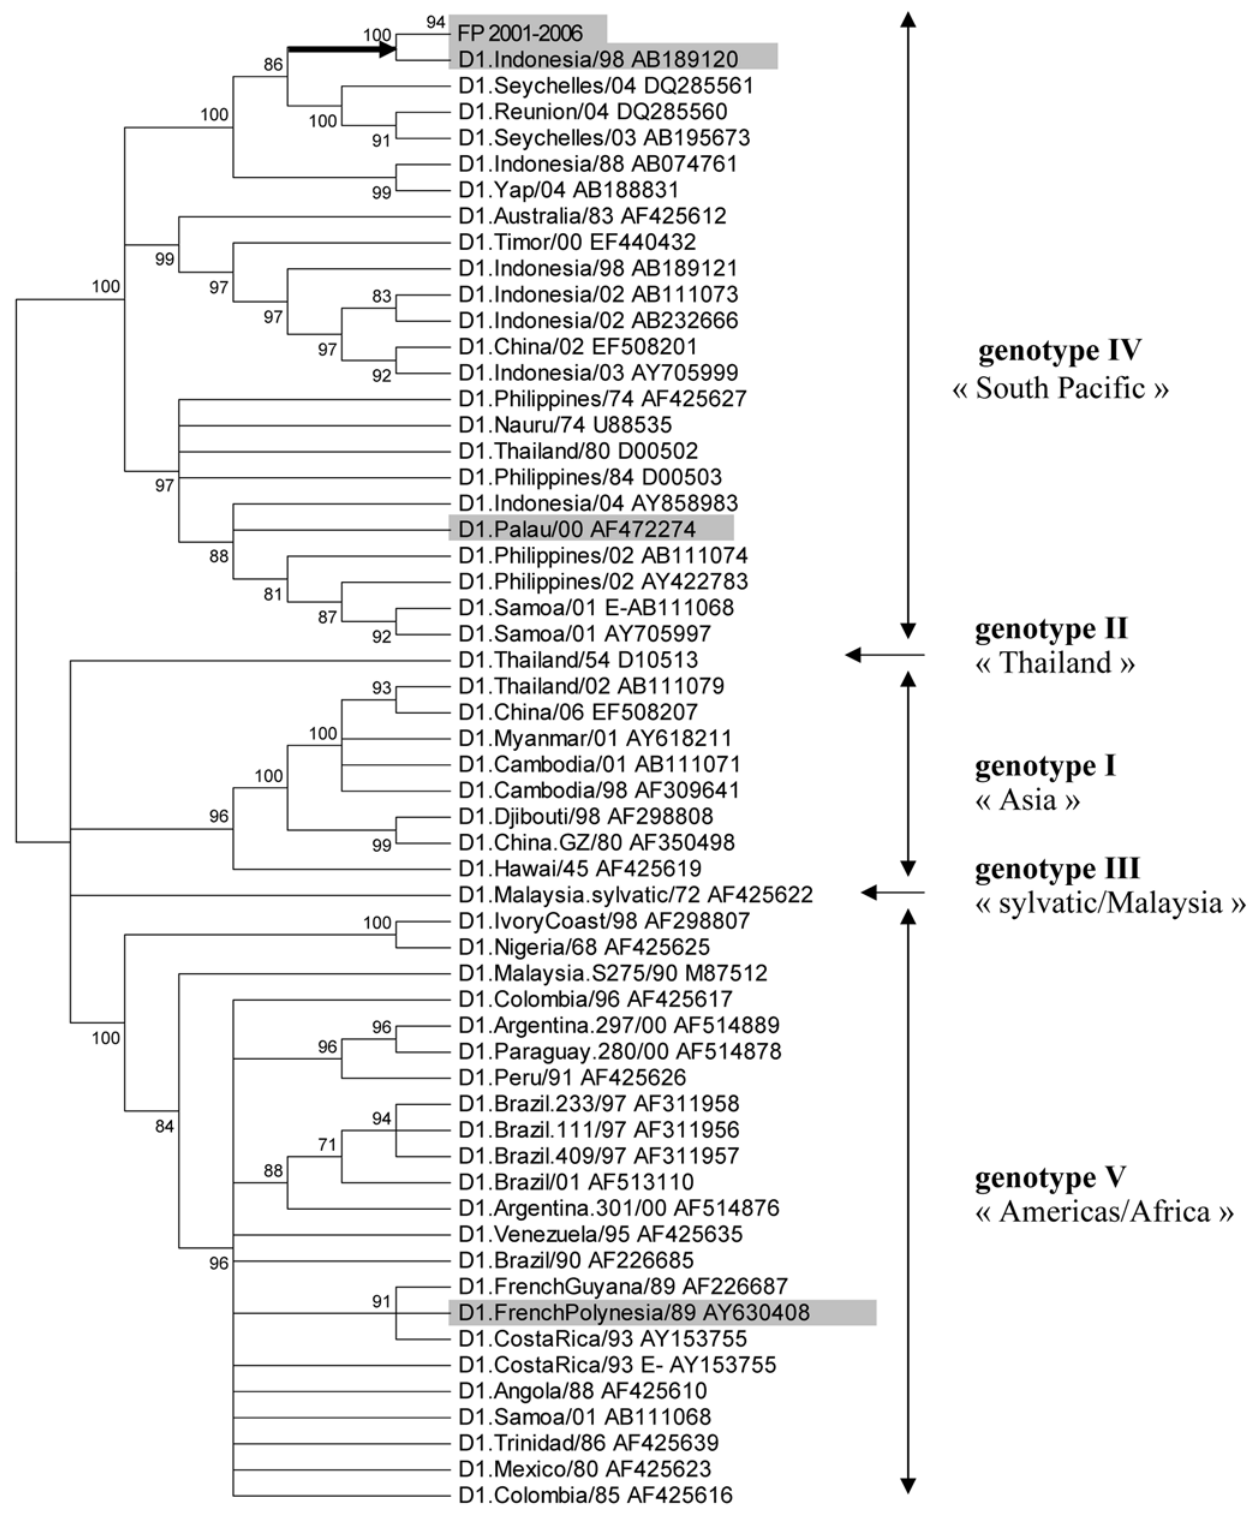
Figure 2. Phylogenetic tree based on 240 DENV-1 nucleotide sequences of 1,759 bp including the E-gene (Neighbor-Joining method, Kimura 2 algorithm). The 181 sequences generated in FP are condensed in the branch named ‘‘FP 2001–2006’’. Taxon names of GenBank sequences correspond to D1.country/last two digits of year of isolation and GenBank accession number. In this condensed tree, branch length is not proportional to genetic distance. Numbers on branches represent bootstrap support for each branch. Five DENV-1 genotypes were identified. The validity of these genotypes, in particular genotype II ‘‘Thailand’’ and genotype III ‘‘sylvatic/Malaysia’’, is supported by previous phylogenetic analyses based on maximum likelihood method [5,29].’’